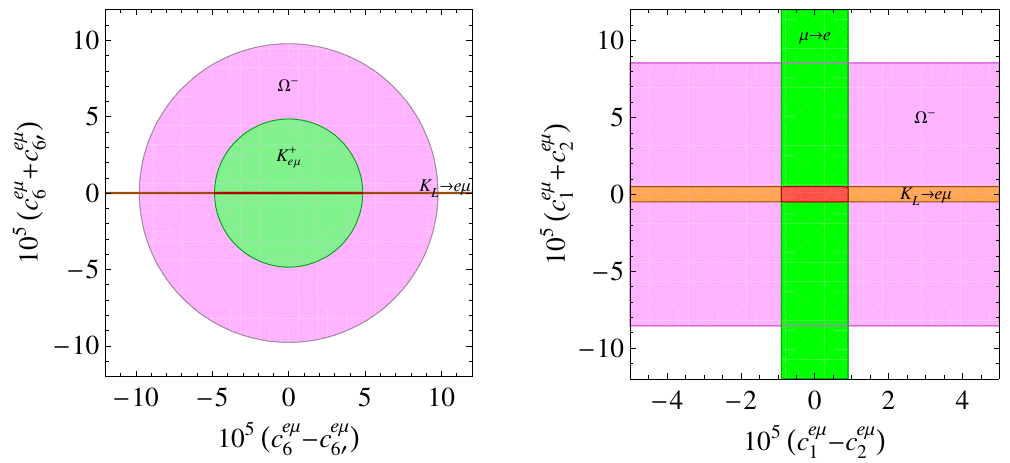
Figure 3 . Comparative constraints on combinations of LFV couplings c (cid:31)(cid:31) (cid:31) produce operators with definite parity, under the assumption that c eµ (cid:30) (cid:31) Ξ TeV, and Ω < 10 − 12 − → − µ ± e ∓ B